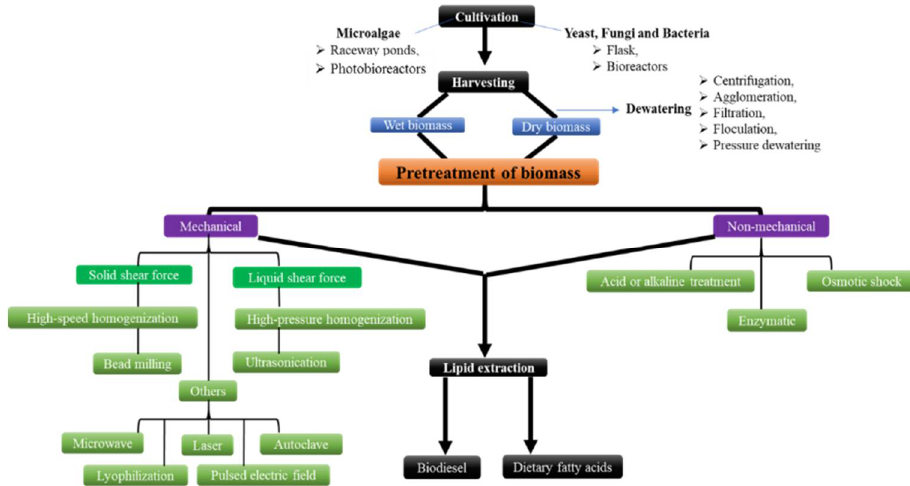
Figure 1. Flowchart showing various pretreatment methods for lipid extraction from oleaginous microbial cells.